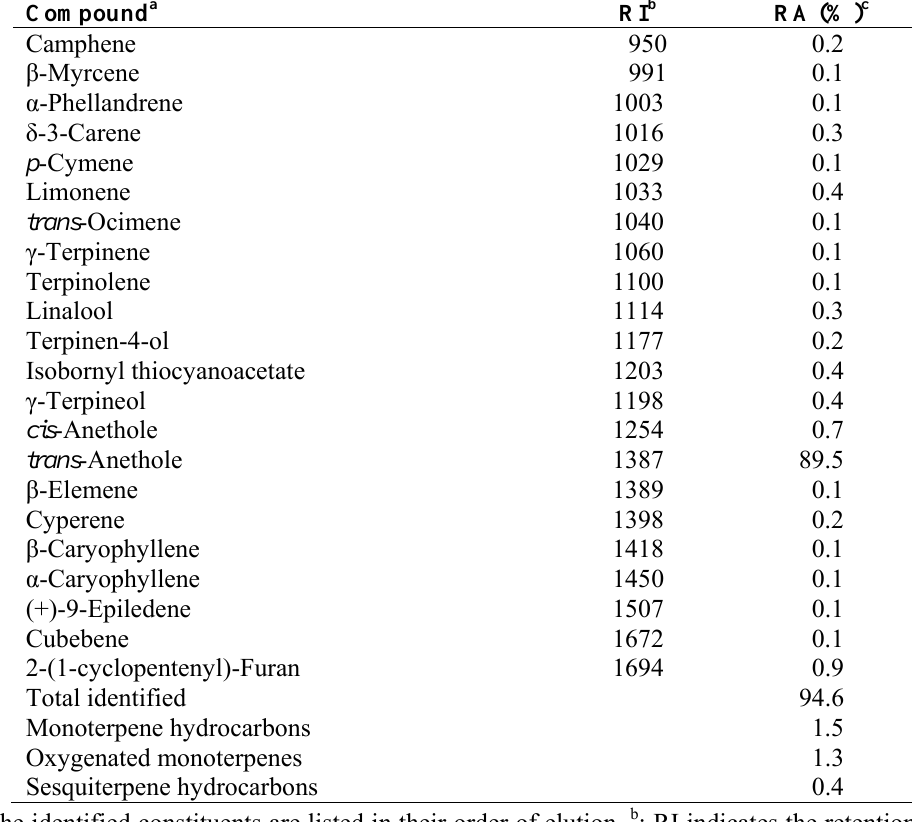
Table 1. Chemical composition of the essential oil from the fruits of I. verum . Compound